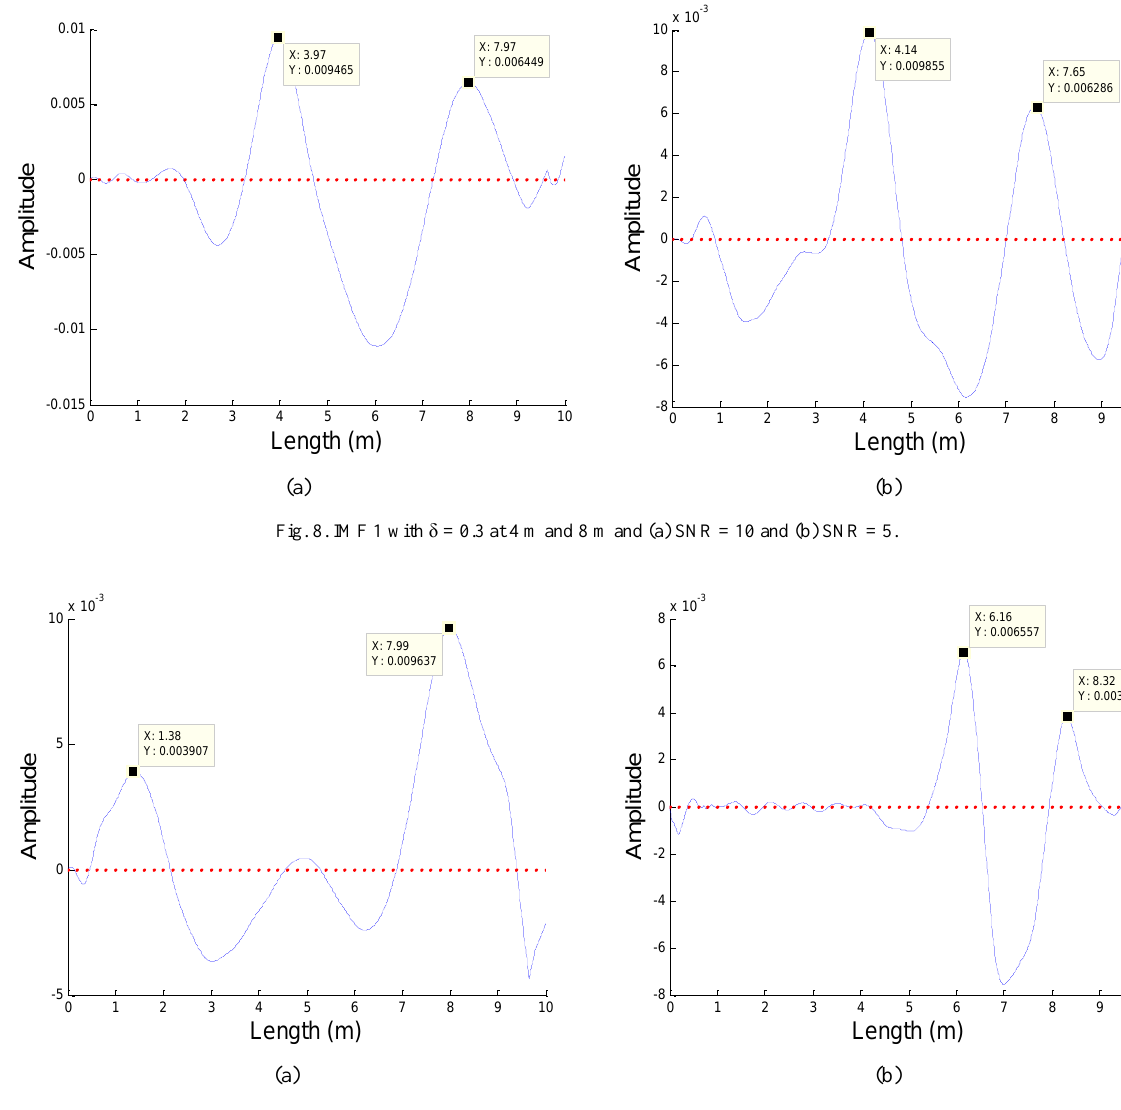
Fig. 9. IMF 1 with δ = 0.3 at (a) 1.5 m and 8 m and (b) 6.5 m and 8